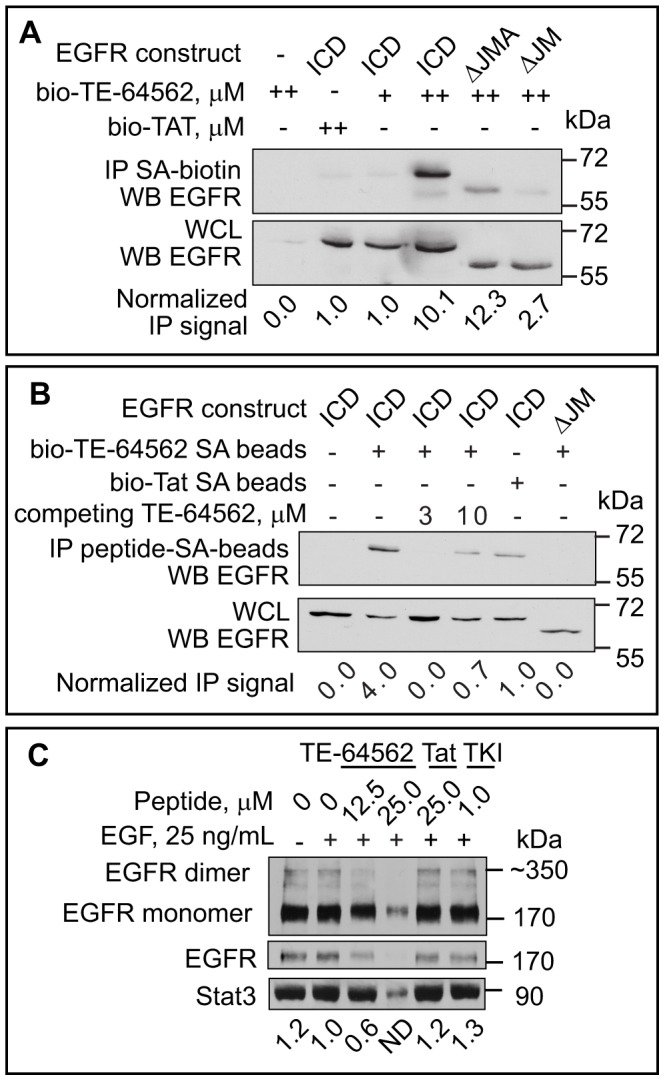
TE-64562 interacts with EGFR and inhibits dimerization.(A) SK-N-MC cells were transfected with the intracellular domain (ICD) of EGFR (645–1186) or the ICD of EGFR lacking the entire JXM region (ΔJM) or the JMA region (ΔJMA). Biotinylated peptides at a concentration of 0.1 µM (+) or 0.5 µM (++) were incubated with SK-N-MC cells for 2 hours and precipitated from cellular lysates with streptavidin-coated beads. The resulting bead-precipitates were analyzed by Western blot for the presence of the EGFR constructs. Results are representative of three independent experiments. (B) Streptavidin beads were pre-bound with biotinylated peptides and incubated with transfected SK-N-MC lysates. The non-biotinylated version of TE-64562 was added to compete for binding in lanes 3 and 4. The resulting bead-precipitates and lysates were analyzed by Western blot for the presence of the EGFR constructs. Results are representative of two independent experiments. (C) Serum starved MDA-MB-231 cells were treated with TE-64562 (12.5 and 25.0 µM), an EGFR specific tyrosine kinase inhibitor (TKI, 1.0 µM), Tat (25.0 µM) or vehicle for 30 minutes, followed by EGF treatment (25 ng/mL) for 10 minutes. Cellular proteins were cross-linked using bis(sulfosuccinimidyl) suberate (BS3), cells were lysed and lysates analyzed by Western blot for EGFR. The quantification of the dimer band is shown. The EGFR dimer band 25.0 µM TE-64562 was not detectable (N.D.). Results are representative of three independent experiments.